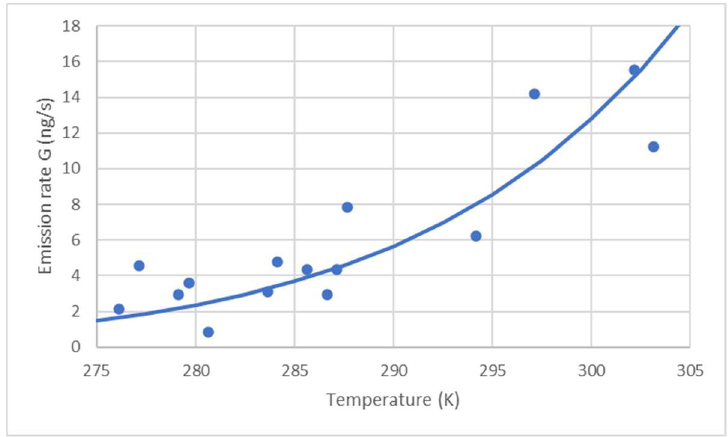
Figure 11. Emission Rate vs. temperature values derived from measurements (dots) and calculated with evaporation liquid model (line).